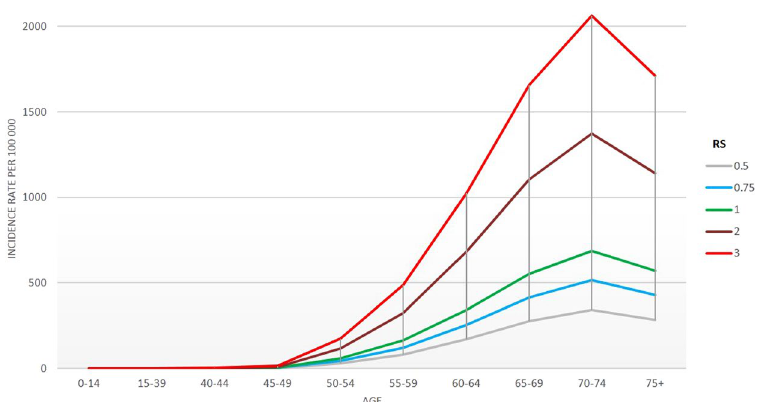
Figure 3. Estimation of prostate cancer incidence in Spain by age (years) and risk score. Color lines indicate age-specific incidence rates of prostate cancer per 100 000 individuals in Spain according to risk score (RS), for a selection of values. The incidence curve for the average individual corresponds to RS = 1. The risk score can be calculated as RS = 2.47 (ERS-0.94) * 3.32 FH * 2.05 (GRS-6.98) , where ERS is the points in the environmental score (average 0.94 in the population), FH is the presence of family history of prostate cancer (0 = no, 1 = yes) and GRS is the points in the genetic score (average 6.98 in the